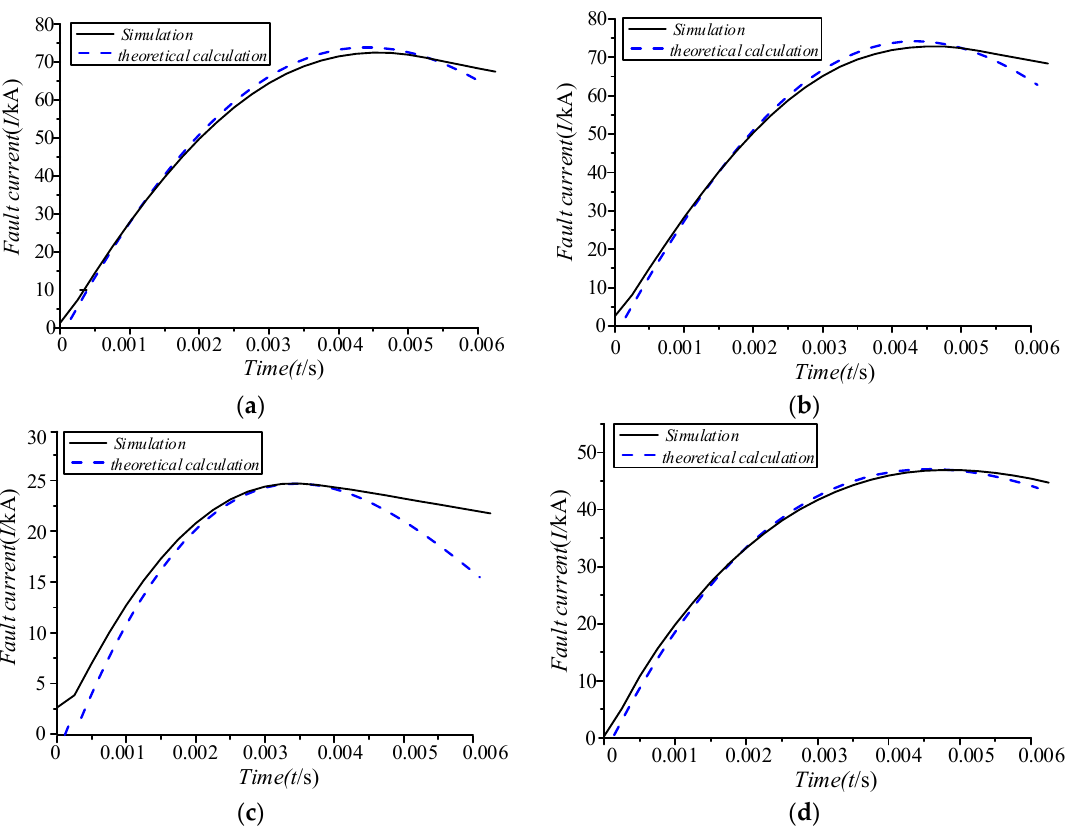
Figure 7. Comparison of theoretical calculations and simulation results. ( a ) Fault current of DCB1 under Fault F2. ( b ) Fault current of DCB3 under Fault F3. ( c ) Fault current of DCB5 under Fault F6. ( d ) Fault current of DCB4 under Fault F8.